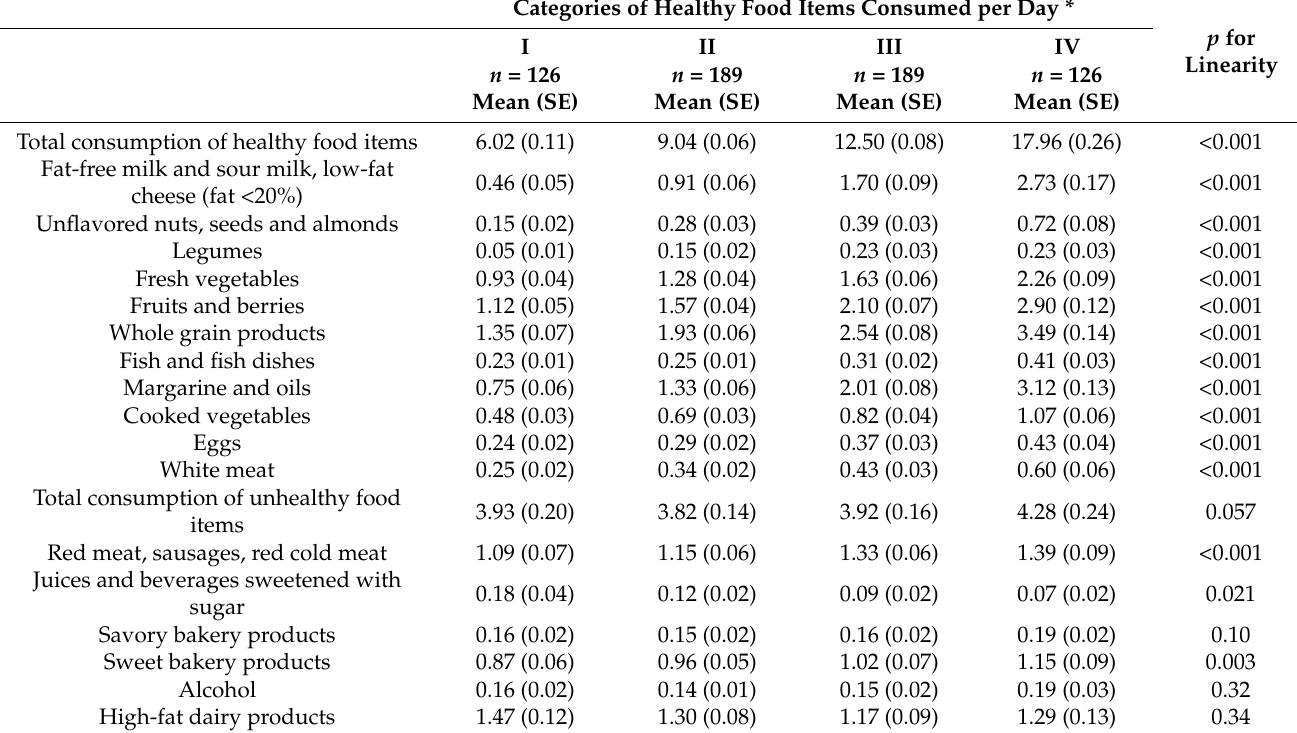
Table 3. Average consumption of healthy and unhealthy food items according to the consumption of healthy food items consumed per day. Categories of Healthy Food Items Consumed per Day